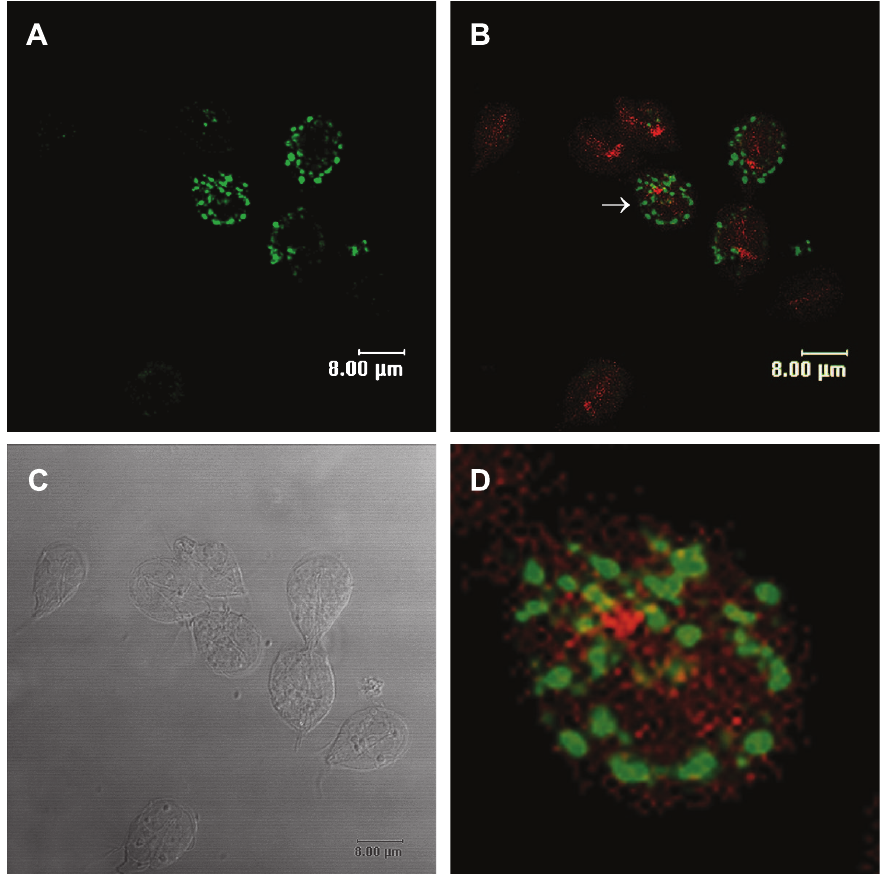
Figure 6. Rab11 co localizes with the actin cytoskeleton during Giardia encystation. ( A )Precysts stained with the anti-Rab11 antibody and a FITC-conjugated goat-anti rat secondary antibody. ( B ) Merged image of cells stained for actin with TRITC-phalloidin and Rab11 with the anti-Rab11 antibody and a FITC-conjugated goat-anti rat secondary antibody. ( C ) DIC image. ( D ) Magnified precyst showing colocalization points between Rab11 and actin. Arrow in B indicates the magnified precyst.